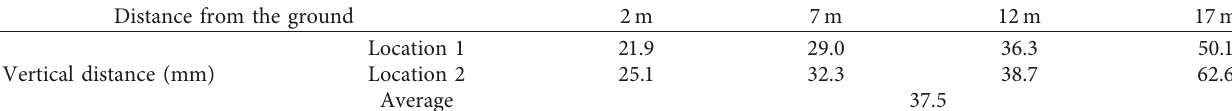
Figure 11: (a) Mud Spillover. (b) Cement shell. (c) Simplified diagram of slurry return. Table 5: Vertical distance between cement shell and pile